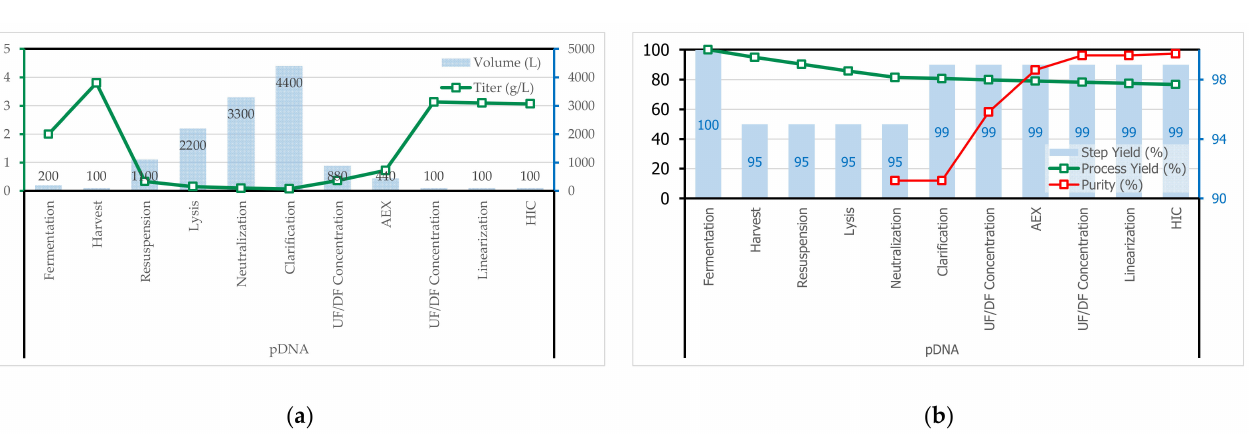
Figure 24. Overview of titer, volume ( a ) as well as purity and yield ( b ) during plasmid manufacturing and linearization.